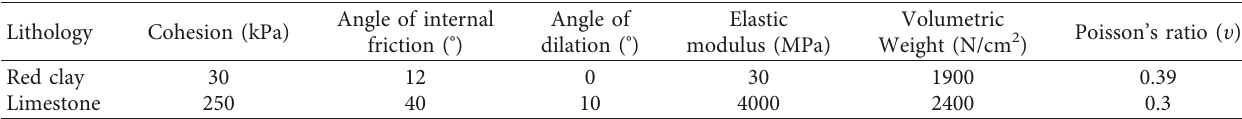
Table 3: Values of the simulation